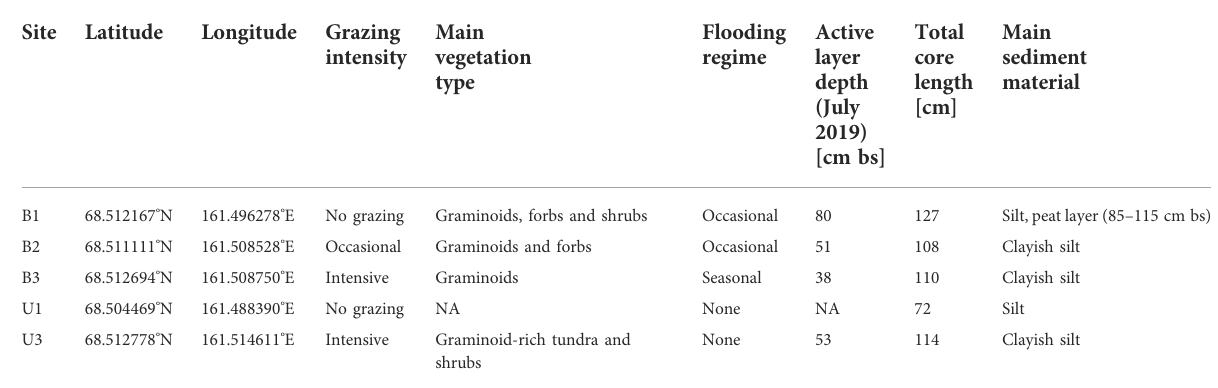
TABLE 1 Sampling site locations and